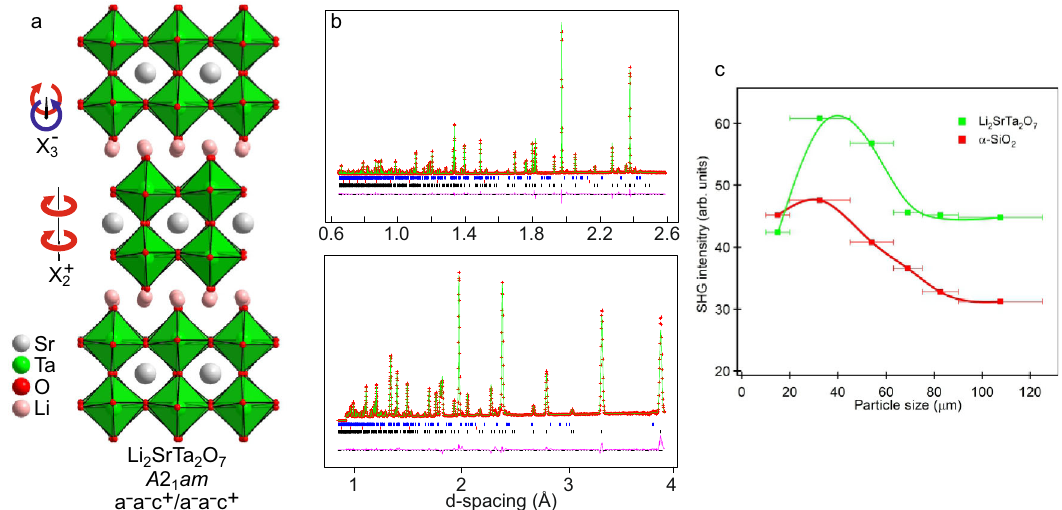
Fig. 1 The polar oxide Li 2 SrTa 2 O 7. a The polar crystal structure of Li 2 SrTa 2 O 7 viewed down the [110] direction. b Observed (red crosses), calculated (green line), and difference (purple line) plots from the structural re fi nement of Li 2 SrTa 2 O 7 against NPD data. Black, red, and blue tick marks indicate peak positions for the majority phase, the vanadium sample holder and a small quantity of Li 3 TaO 4 , respectively. c Particle-size dependent SHG data from Li 2 SrTa 2 O 7 compared with an α -SiO 2